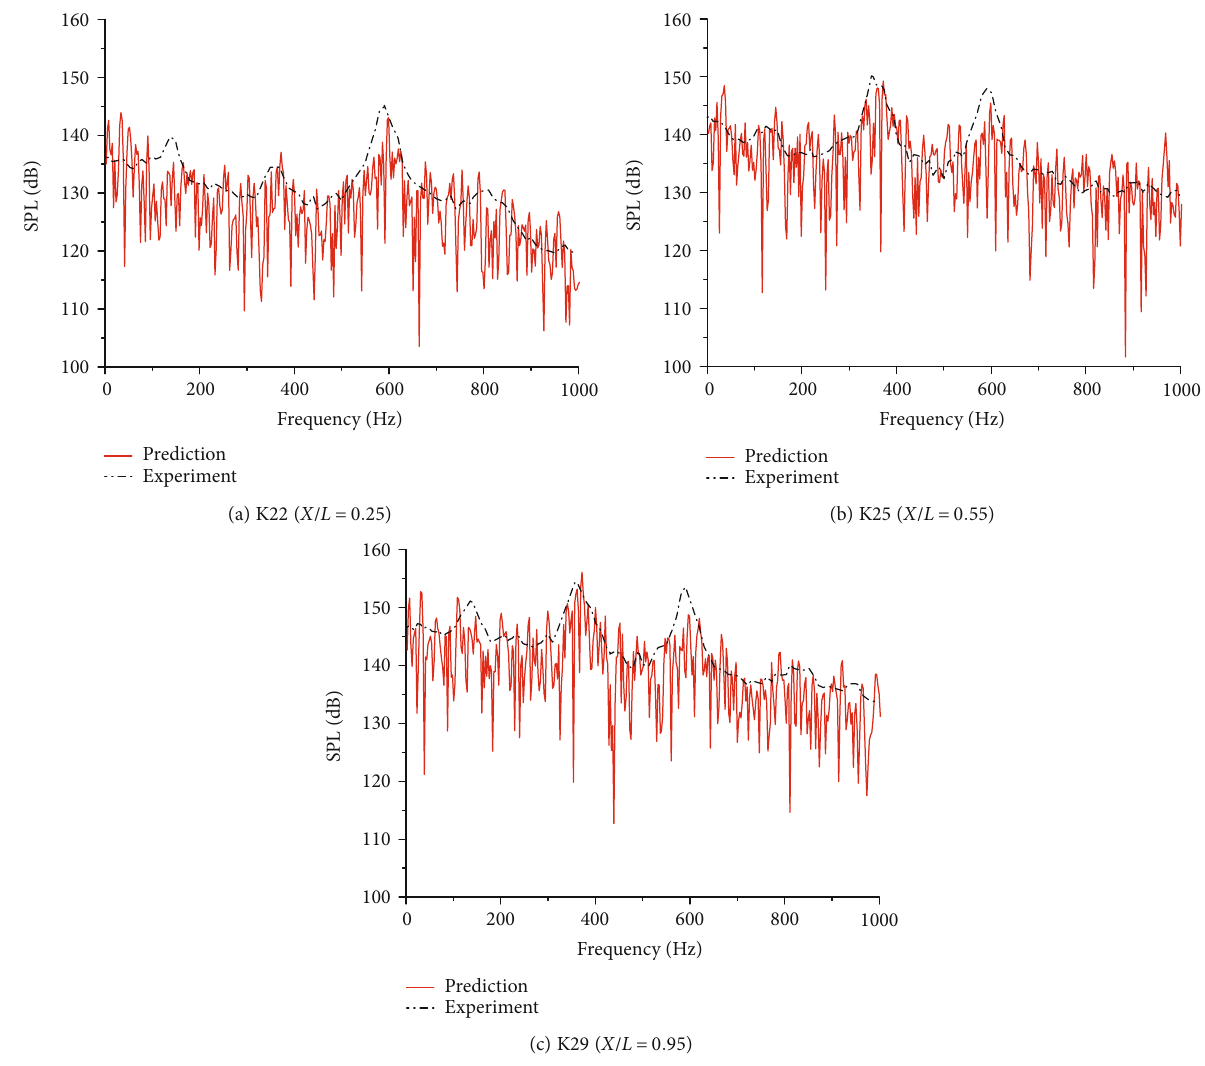
Figure 7: Comparison of spectrum between calculation and test at Ma = 0 : 85